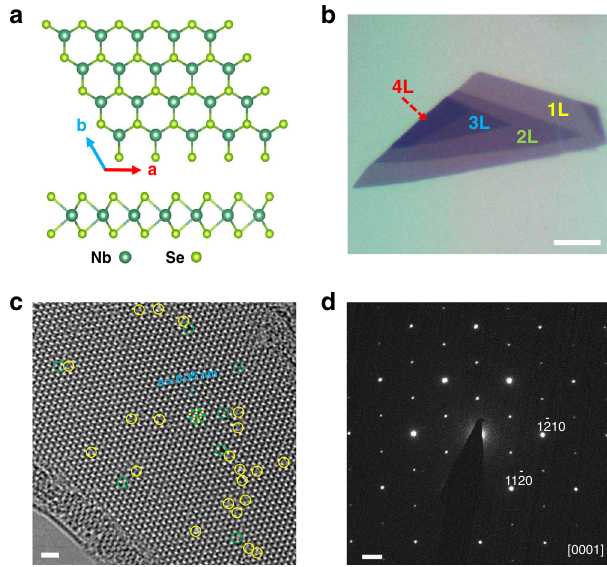
Fig. 1 Crystal structure and characterization of NbSe 2 . a . Top and side views of NbSe 2 crystal. Nb atoms (shown dark green) are sandwiched between two layers of Se (shown light green) atoms. Monolayer NbSe 2 exhibits spatial inversion symmetry breaking because the Nb and Se sites are not equivalent. b . Optical image of a few-layer fl ake of NbSe 2 cleaved on a SiO 2 /Si substrate with a spin-coated PMMA/MMA polymer on it. The number of layers is labeled. Scale bar: 5 μ m. c . High-resolution TEM image taken from a NbSe 2 fl ake suspended on a TEM grid, in which the Nb and Se atomic columns are marked by green and yellow dots. And the selected point defects located at Nb and Se sites are highlighted by green and yellow circles, respectively. Scale bar: 1 nm. d . SAED taken from the NbSe 2 fl ake along [0001] zone axis. Scale bar: 2 nm − 1